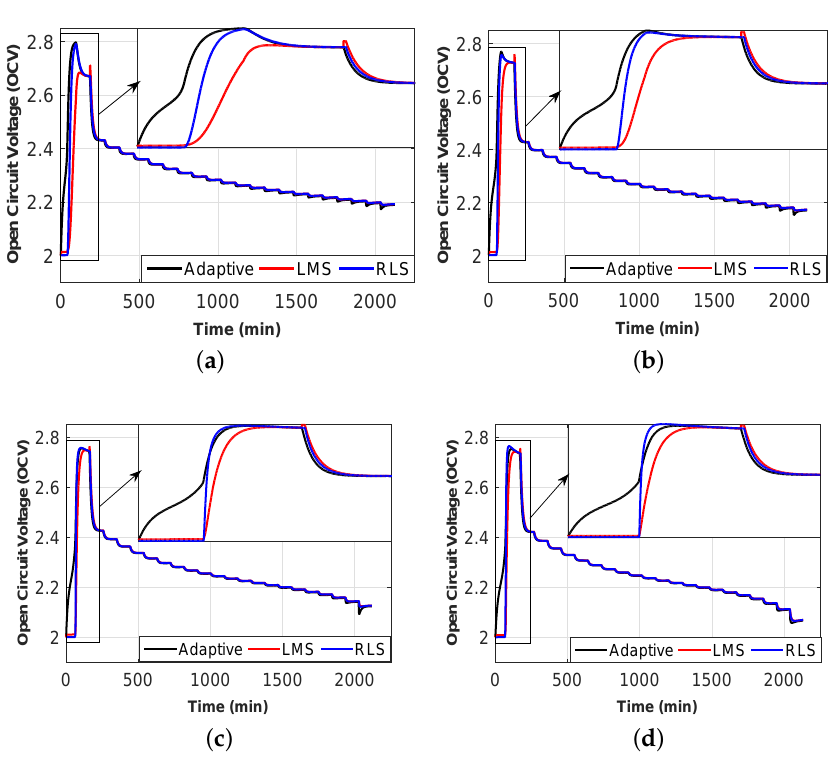
Figure 8. Open-circuit voltage estimation for different temperatures in discharge mode. ( a ) 0 ◦ C; ( b ) 10 ◦ C; ( c ) 25 ◦ C; and ( d ) 40 ◦